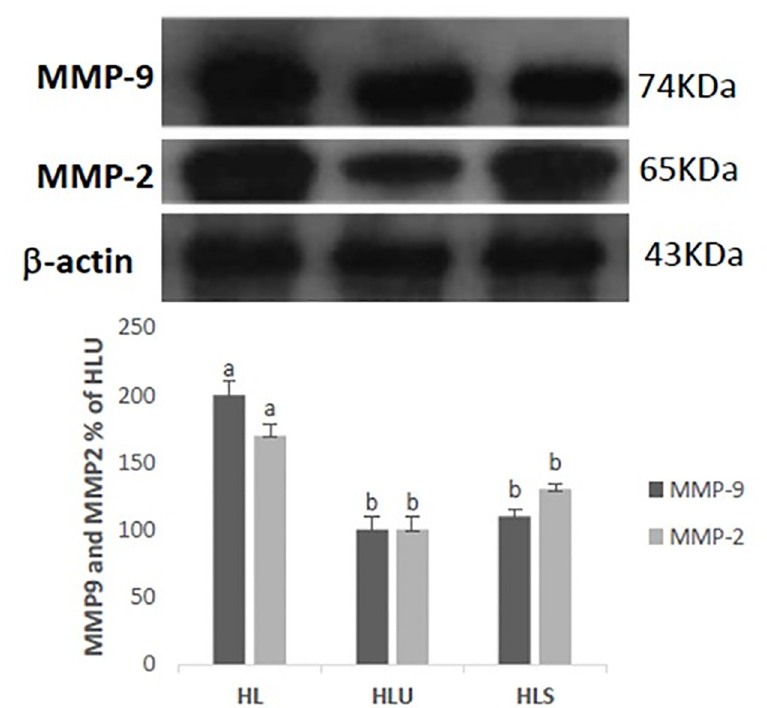
Fig 3. Western Blot analysis of the expression of metalloproteins 2 (MMP-2) and 9 (MMP-9) and β -actin protein in LDLr -/- mice fed a high fat diet (HL), LDLr -/- mice fed with a hyperlipidic diet defined with grape juice (HLU), LDLr -/- mice fed an open hyperlipidic diet with simvastatin (HLS). Values expressed as mean ± standard error of the mean. (ANOVA + Tukey test).